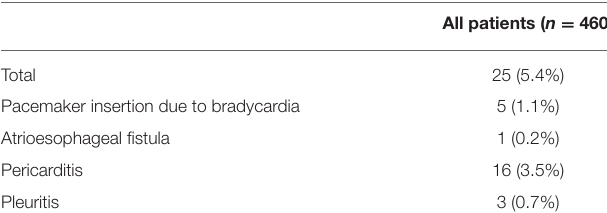
TABLE 4 | Procedure-related complications.